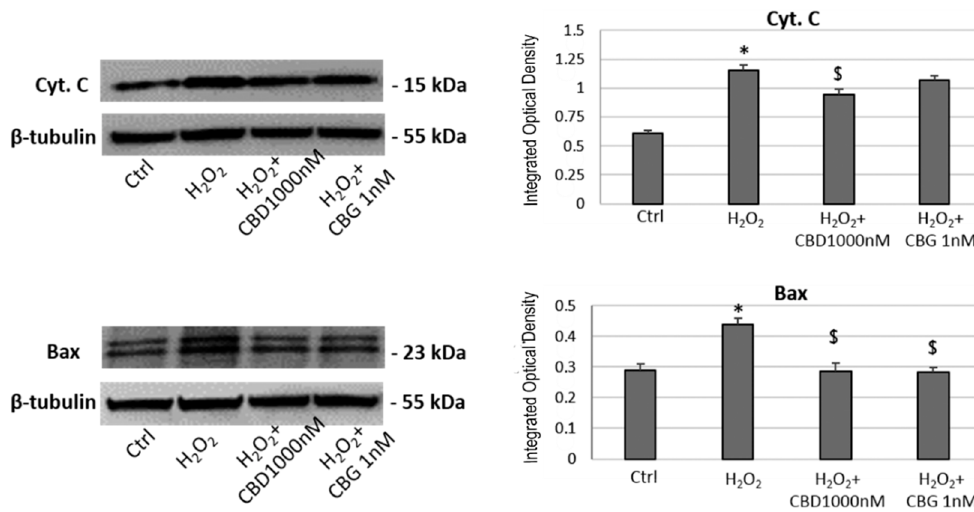
Figure 4. Western blotting analysis in CTX-TNA2 astrocyte cell line exposed to 1000 nM CBD and 1 nM CBG and challenged with H 2 O 2 for 24 h. The graph shows the mean ± SD ( n = 3). ANOVA, * p < 0.05 vs. Ctrl group; $ p < 0.05 vs. H 2 O 2 group. A representative western blotting for each protein is shown.